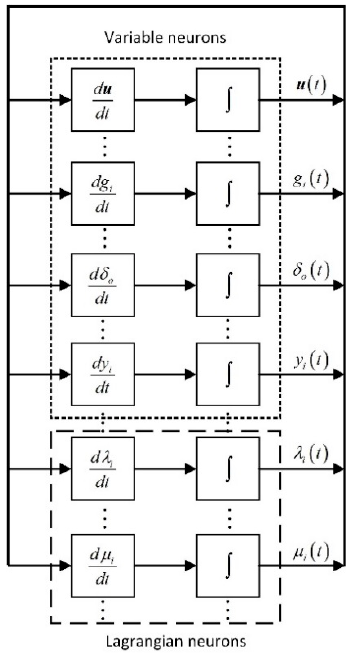
Figure 1. The structure of the proposed LPNN with unknown